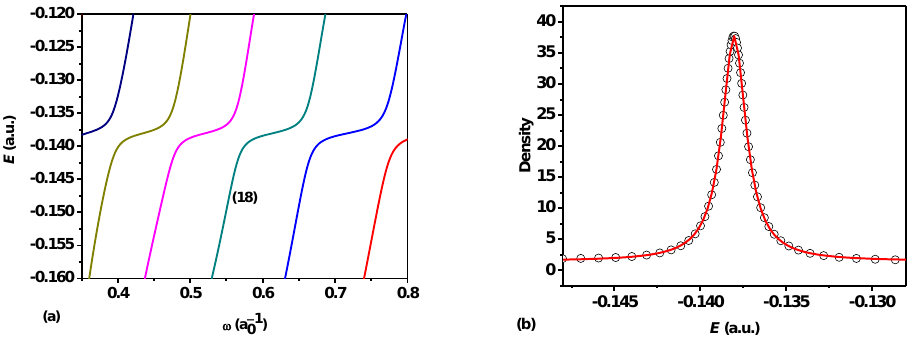
Figure 1. ( a ) Stabilization diagram for the 1 S e state of Mμ − at 𝜆 = 0.01 (the number 18 in the diagram indicates the 18th energy level). ( b ) Calculated densities (circles) and Lorentzian fits (solid line and the best fit) for the 1 S e state of Mμ − at 𝜆 = 0.01 .